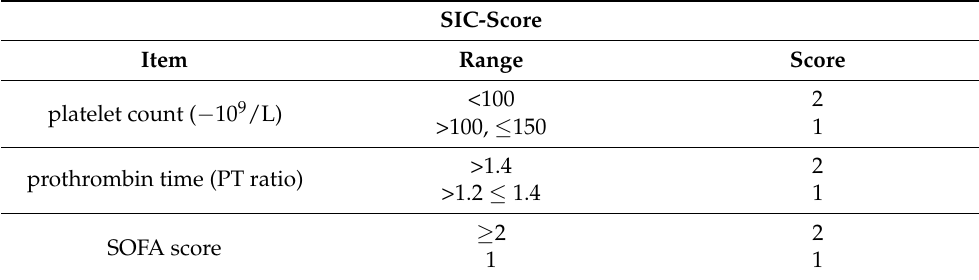
Table 3. Sepsis-induced coagulopathy (SIC) score by the International Society on Thrombosis and Hemostasis